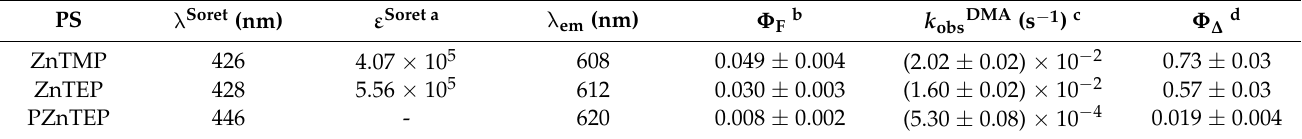
Table 1. Spectroscopic and photodynamic properties of ZnTMP, ZnTEP, and PZnTEP in